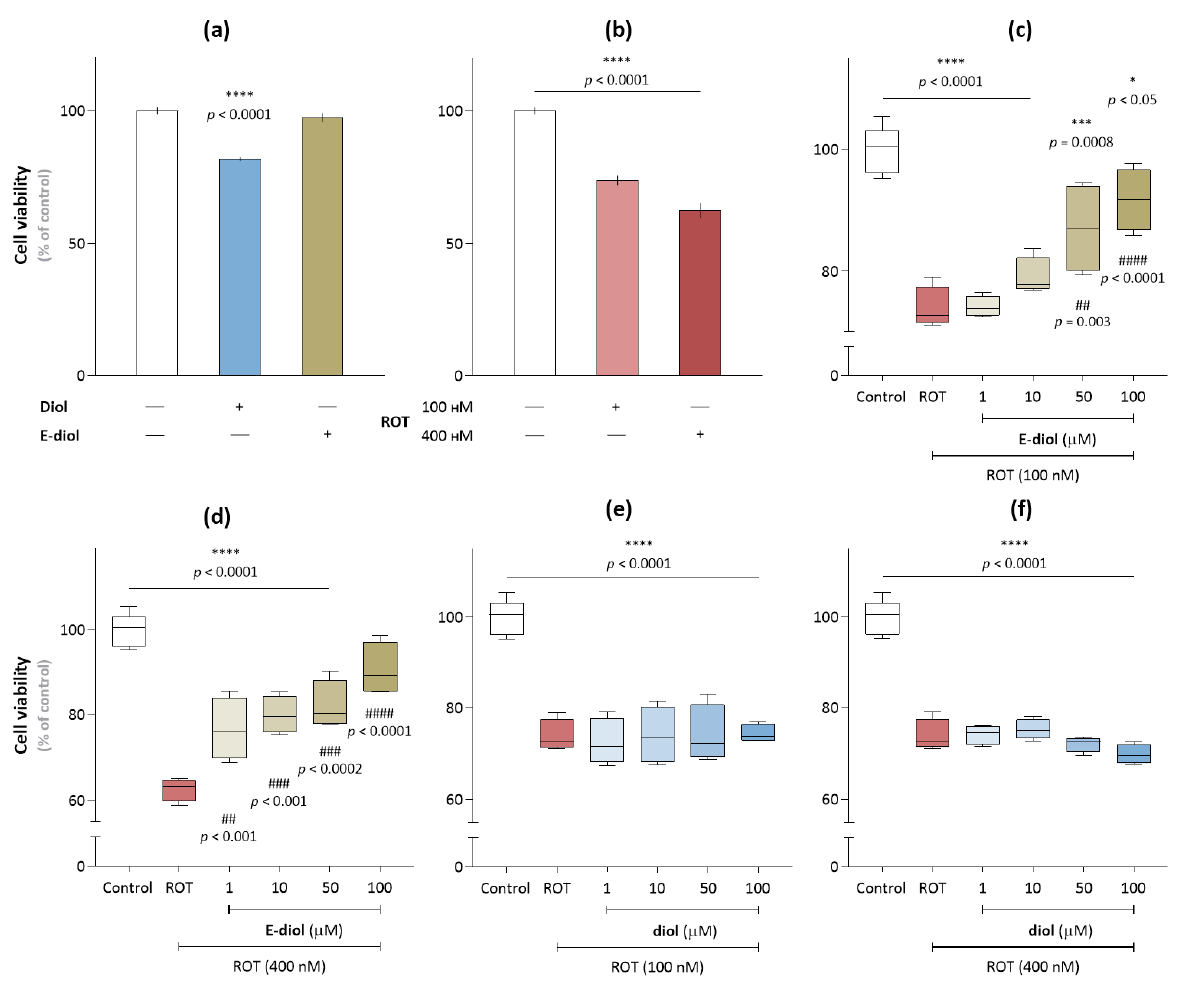
Figure 3. Viability of SH-SY5Y cells assessed by MTT analysis. Analysis of the viability of SH-SY5Y cells (10,000 cells per well) in the presence of ( a ) the studied compounds and ( b ) rotenone. The effect of diol and epoxidiol in the concentration range from 1 µ M to 100 µ M on the survival of SH-SY5Y cells in the rotenone presence at concentrations of 100 nM ( c , e ) and 400 nM ( d , f ). The data are presented as an average ± SEM. ****, p ≤ 0.0001, ***, p ≤ 0.001 and *, p ≤ 0.05 versus control; #### , p ≤ 0.0001, ### , p ≤ 0.001 and ## , p ≤ 0.01 (one-way ANOVA and Dunnett’s multiple comparison tests).